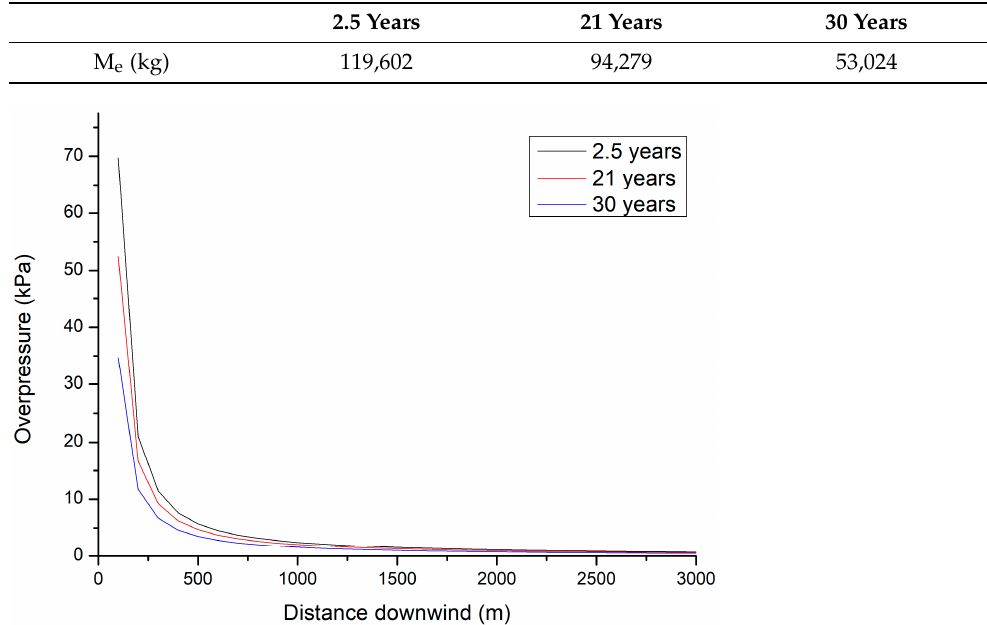
Table 7. Flammable amount in the cloud at 2.5, 21 and 30 years.